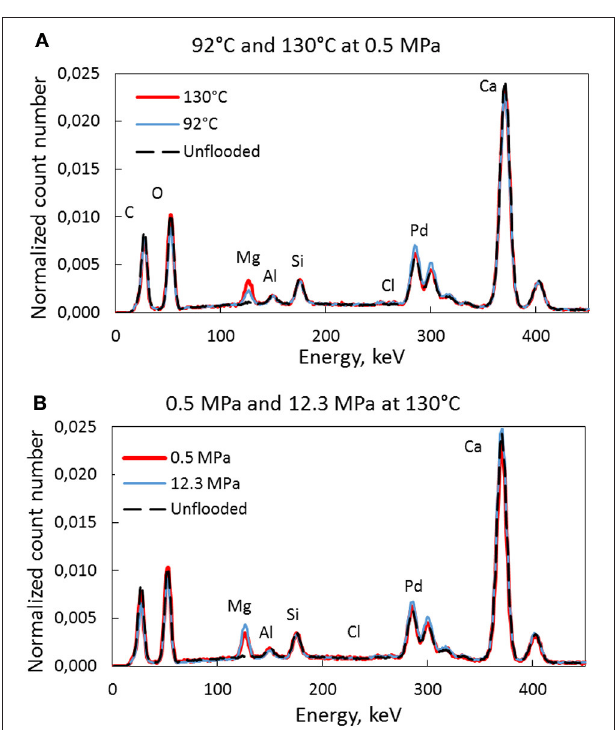
FIGURE 12 | EDS spectra of the tested core material with peaks for the different elements. The effect of temperature is shown in (A) where more Mg is seen for the high temperature test. This is the same trend as for the high-stress experiment compared to the low stress experiment in (B) .